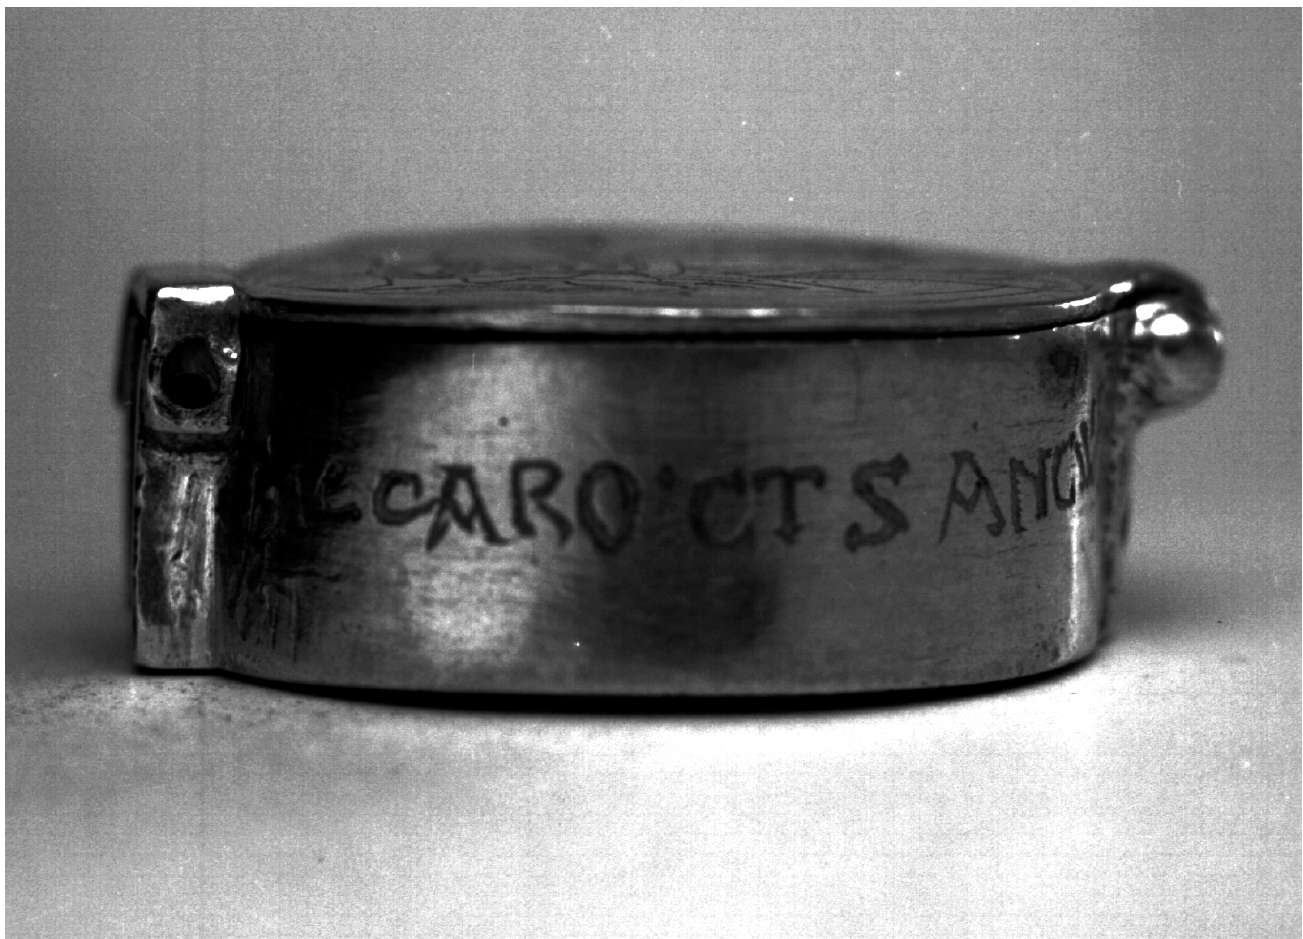
Figure 2. Outer reliquary capsule associated with the sainte Vertu, silver gilt and niello, late eleventh century, treasury of the abbey Saint-Sauveur de Charroux (Photo by permission: Ferron © Ministère de la Culture, Médiathèque du patrimoine et de la photographie, diffusion. RMN-GP).